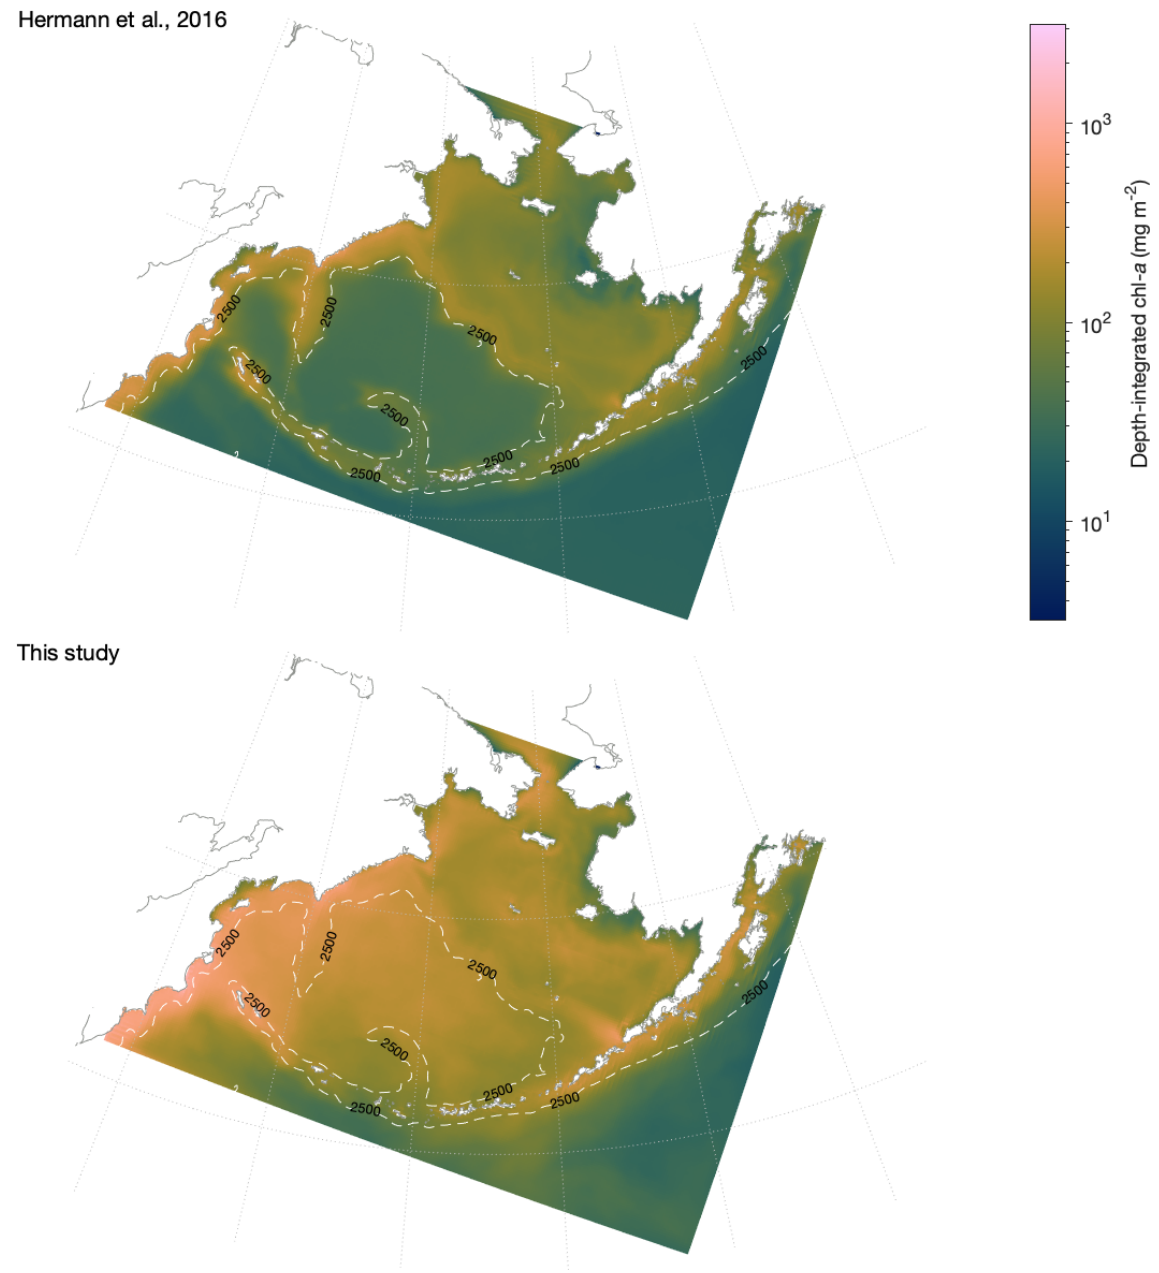
Figure B3. Mean depth-integrated chlorophyll in the Hermann et al. (2016) version of BESTNPZ versus this study. The contour line indicates the 2500m